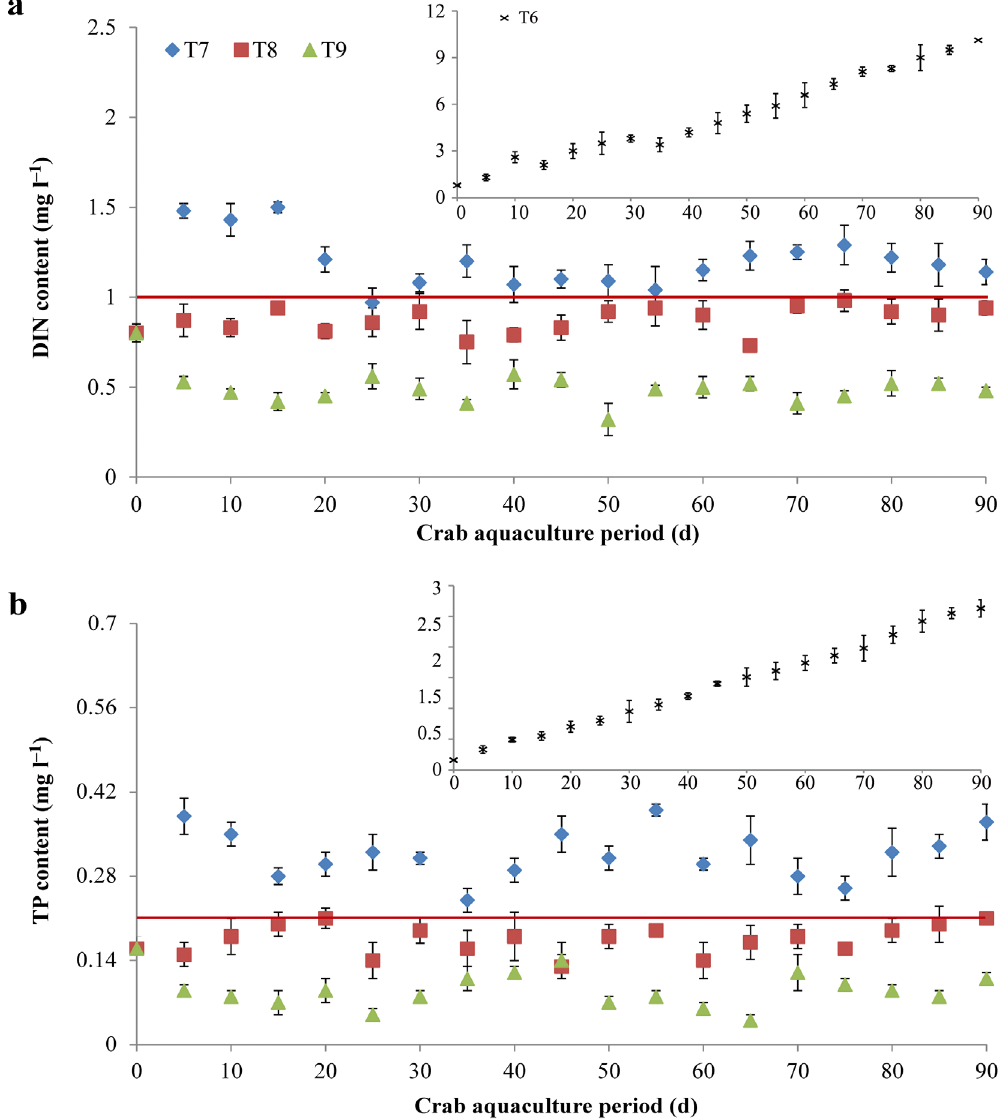
Fig. 5. Dynamic variations of dissolved inorganic nitrogen (DIN) and total phosphorus (TP) contents during crab aquaculture with applications of 0 g l −1 (T6) (insets), 2 g l −1 (T7), 4 g l −1 (T8) and 6 g l −1 (T9) of biochar-immobilized ammonia nitrogen and phosphate removal strains, respectively. Red line: clean criterion of dissolved inorganic nitrogen and TP contents for aquaculture according to the Chinese Environmental Quality Standard for Surface Water (GB3838-2002). Error bars: